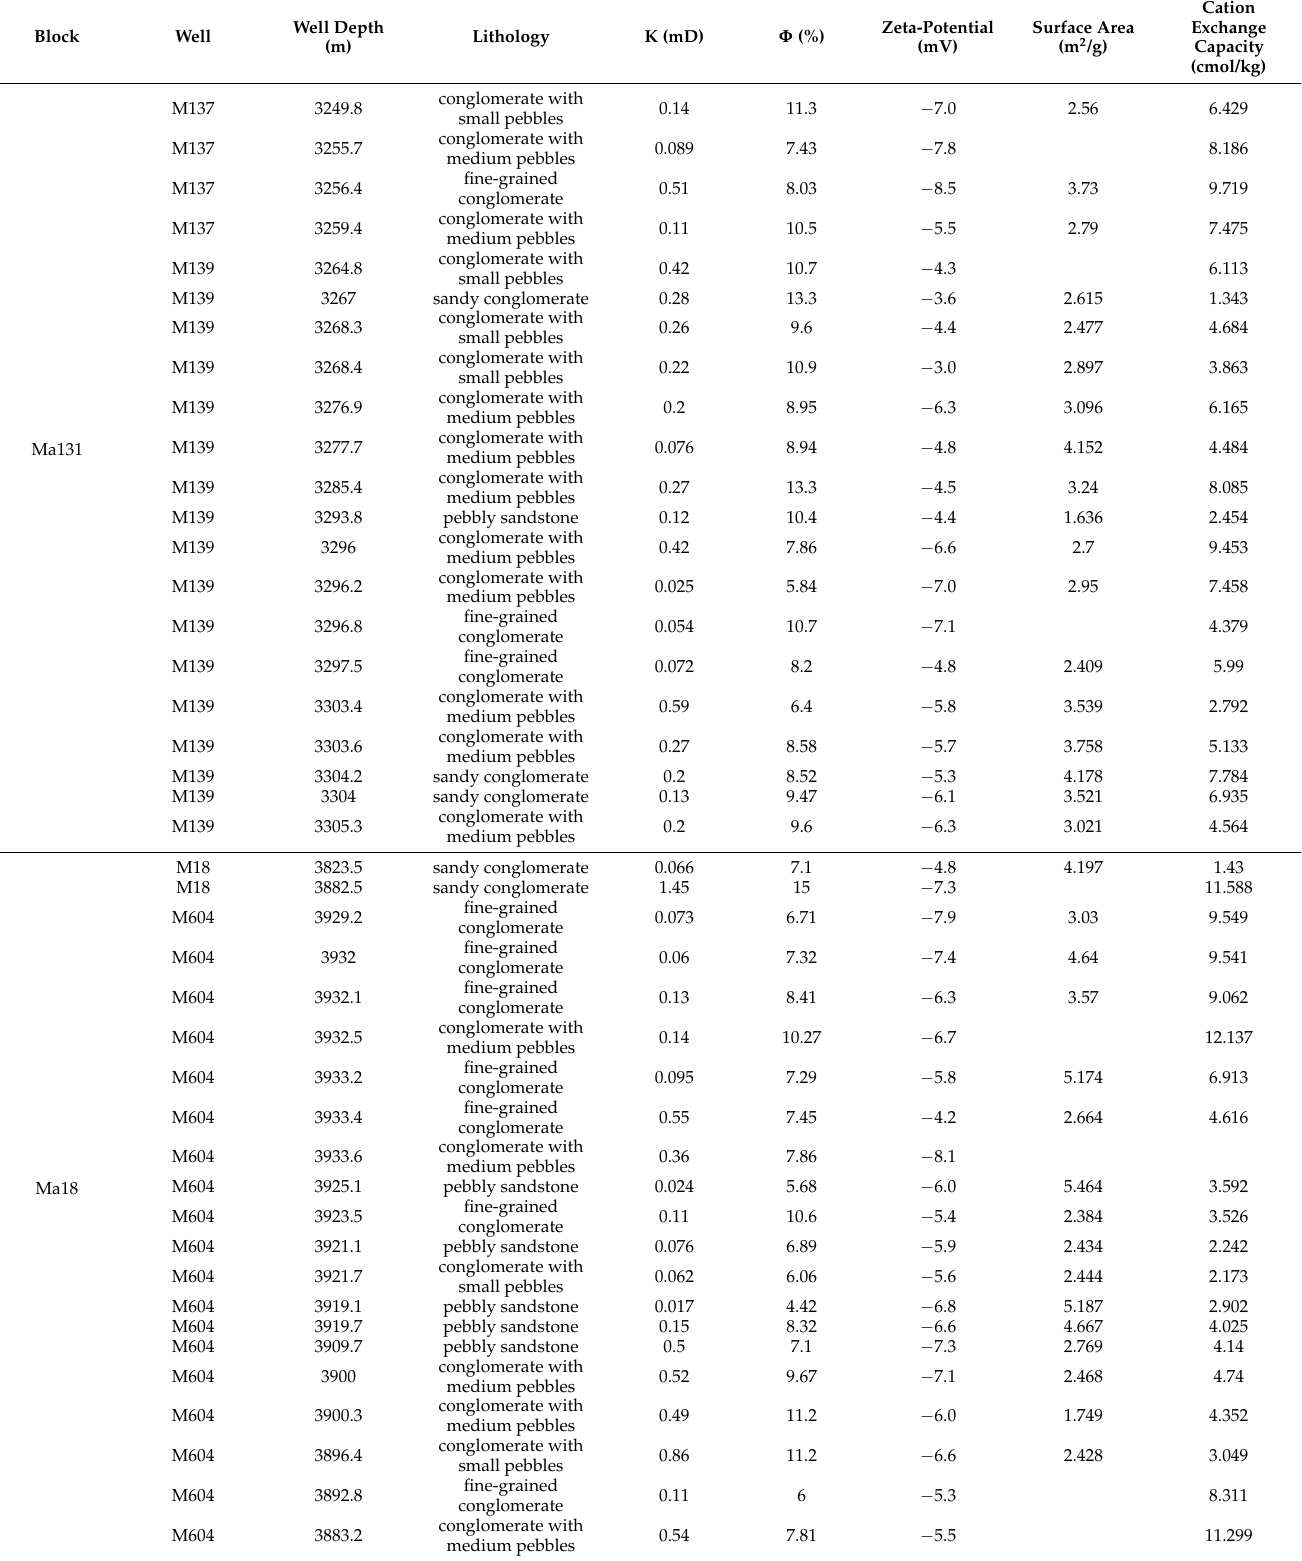
Table 2. Interface properties of the samples from the Mahu